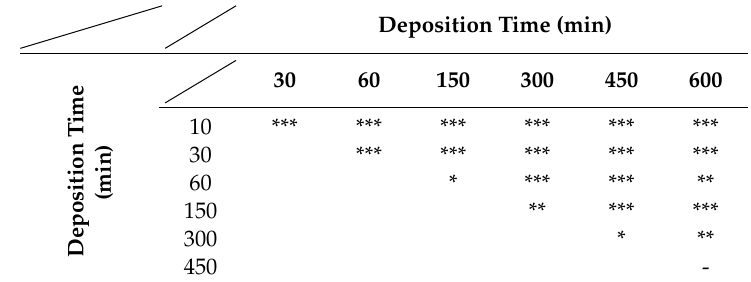
Table 4. Statistical analysis of the number of pores across a variety of surfaces. p > 0.05: p < 0.05: *, p < 0.01: **, p < 0.001: ***.